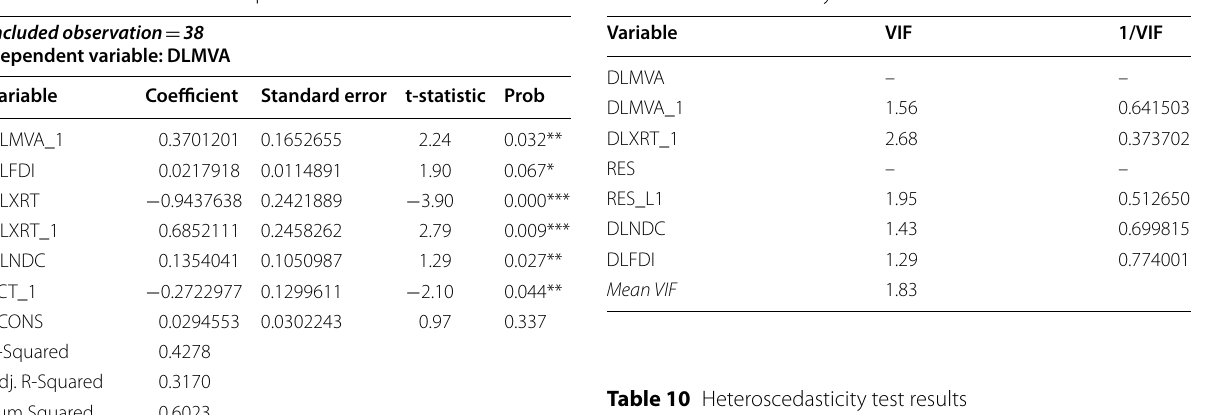
Table 7 Estimated results for parsimonious model of DLMVA